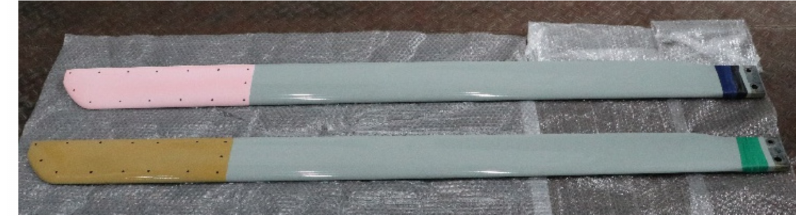
Figure 2. Test blades coated with PSP and